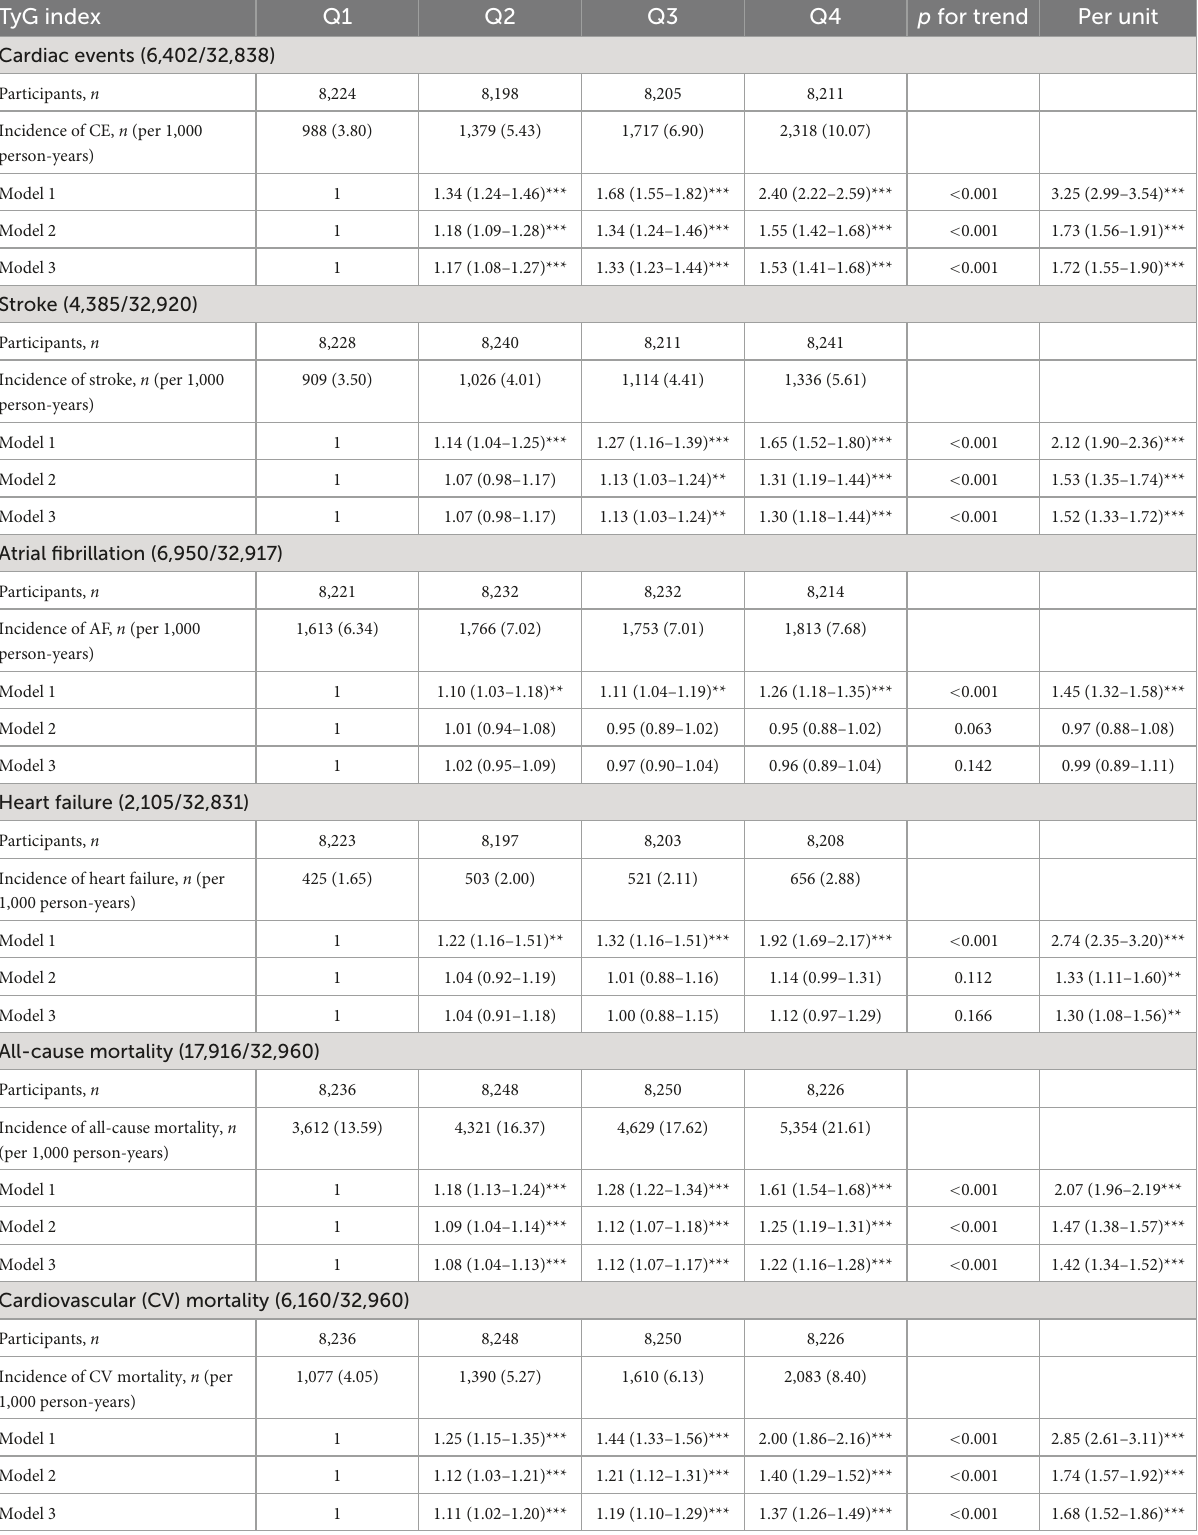
TABLE 3 Incidence of CVD events and all-cause as well as CV mortality in relation to quartiles of TyG index in